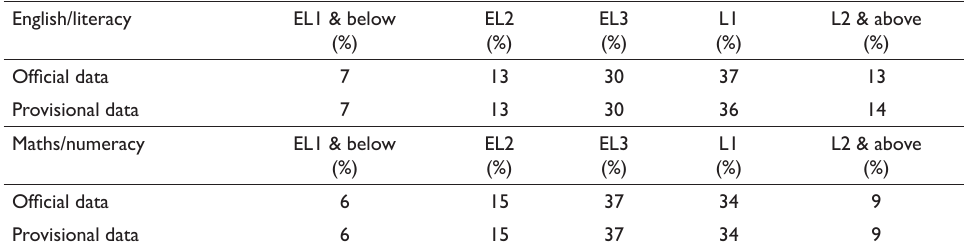
Table 5: Differencesbetweenofficialdataandprovisionaldata English/literacy